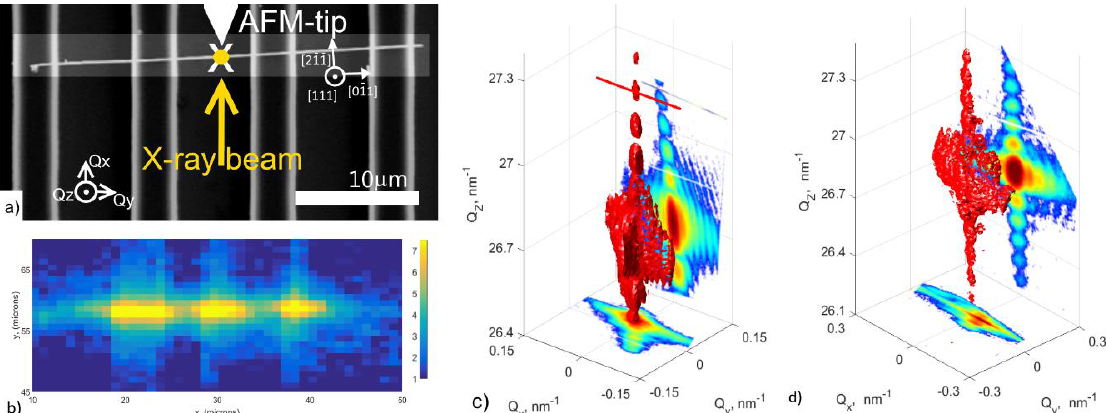
Figure 1. ( a ) Scanning electron microscopy image of selected Au nanowire. The yellow full dot represents the X-ray beam focus while the yellow arrow indicates the direction of the incident X-ray beam. ( b ) Scanning X-ray diffraction map of the sample recorded at the Au 111 Bragg peak. Three-dimensional iso-surface of the intensity distribution around the Au 111 Bragg peak of the gold nanowire recorded by rocking scan ( c ) before and ( d ) after the three-point bending test (sample detector distance has been changed). AFM = Atomic Force Microscopy.